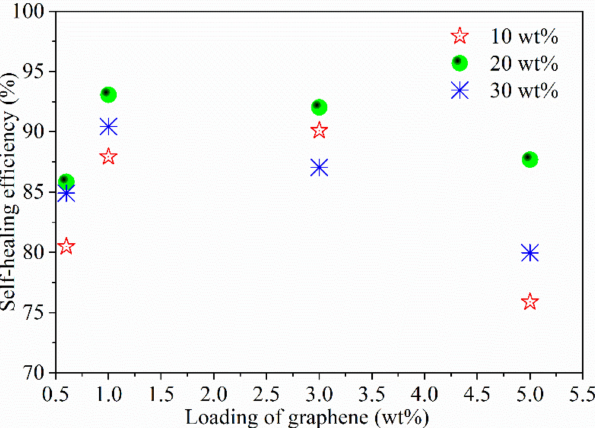
Figure 14. Self-healing efficiencies of the composite films prepared with different initial TPU concen- trations and graphene loadings.